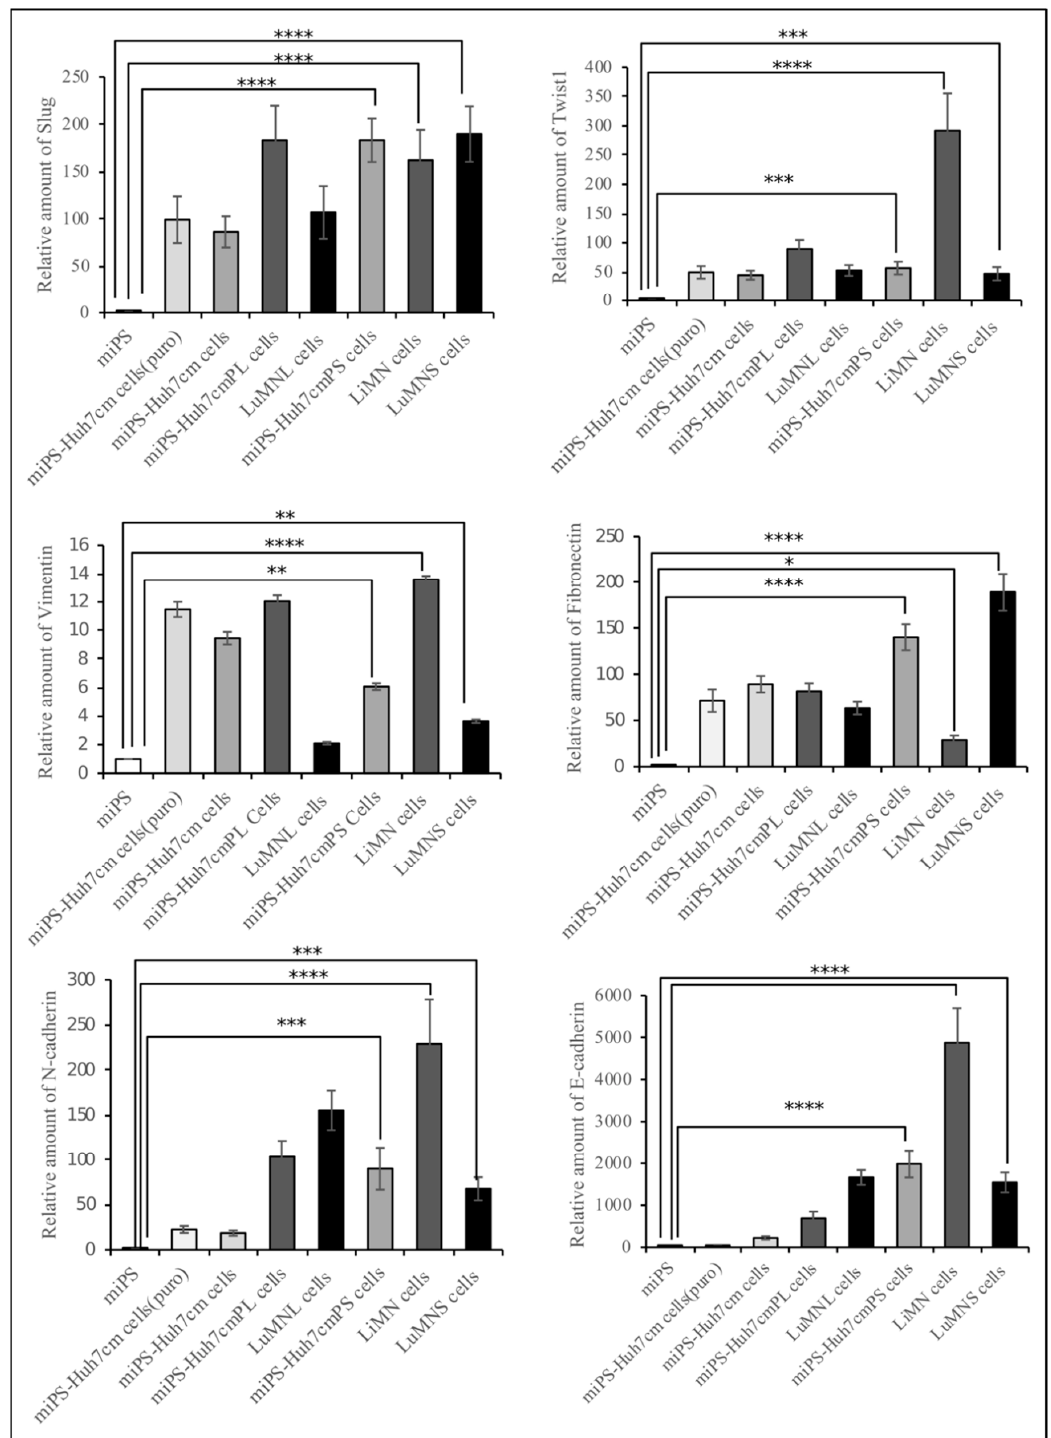
Figure 8. Real-time-qPCR analysis of metastatic markers (Slug and Twist1), mesenchymal markers (Vimentin, N-cadherin and fibronectin) and epithelial marker (E-cadherin) in cells derived from intrahepatic transplantation (miPS-Huh7cmPL cells and LuMNL cells) and intrasplenic transplantation-derived cells (miPS-Huh7cmPS cells, LiMN cells and LuMNS cells) in comparison with miPS-Huh7cm cells and miPS (* p < 0.01, ** p < 0.001, *** p < 0.0001, **** p < 0.00001).